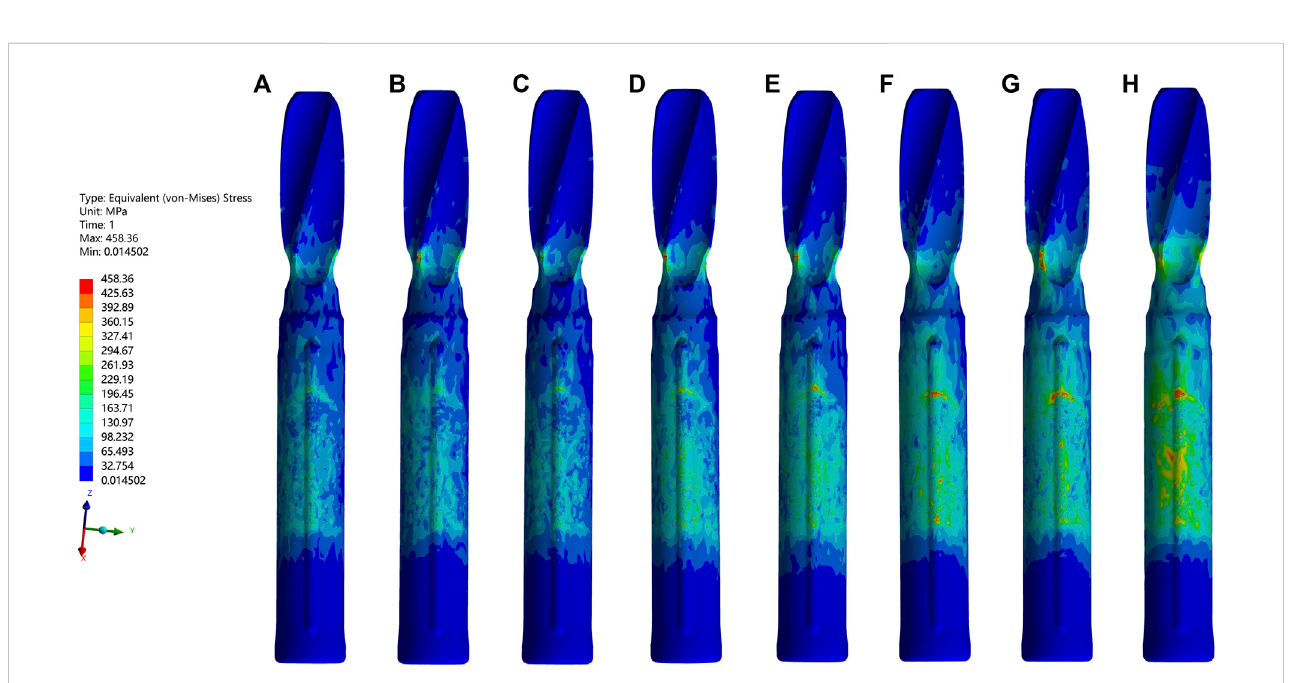
FIGURE 5 The VMS values and nephograms of the blades under the dynamic climbing hip load were exhibited. The order was the same as it was in Figure 4. From images (A – H) , the peak value of each blade model gradually increased and the highest one of 458.36 MPa appeared in (H)